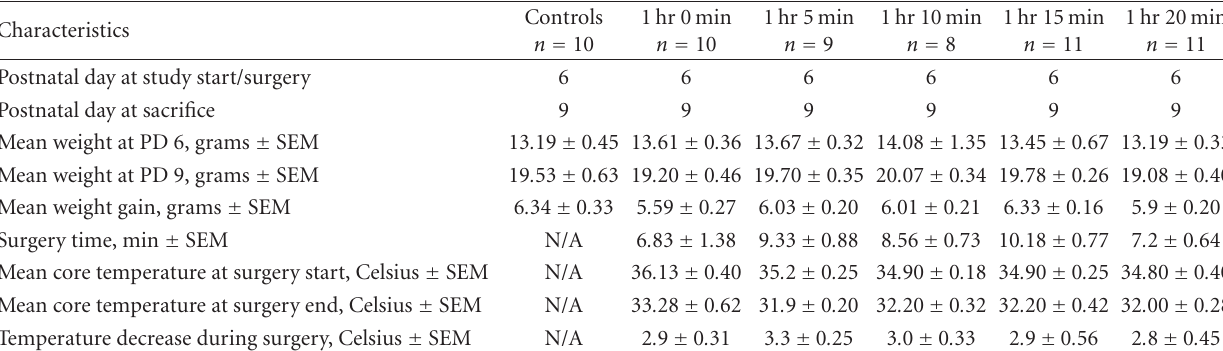
Table 1: Summary and comparison of study animal characteristics by hypoxia